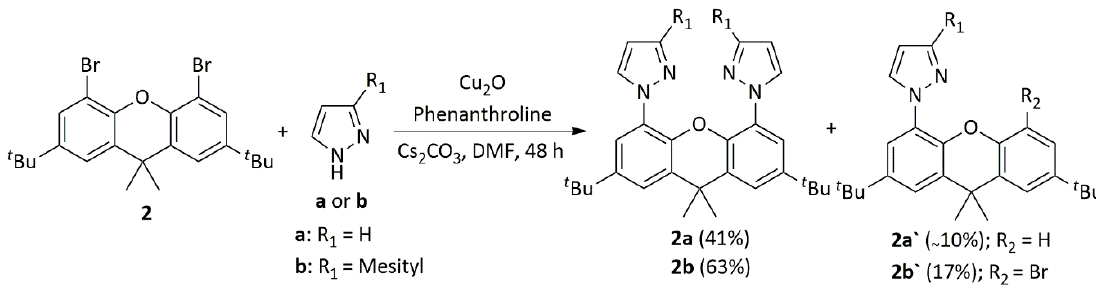
Figure 2. Molecular structures of 1 , 1a , 2a , 2b and 2b‘ with the key atoms labelled (thermal ellipsoids drawn at 50% probability). For clarity, hydrogen atoms have been omitted.